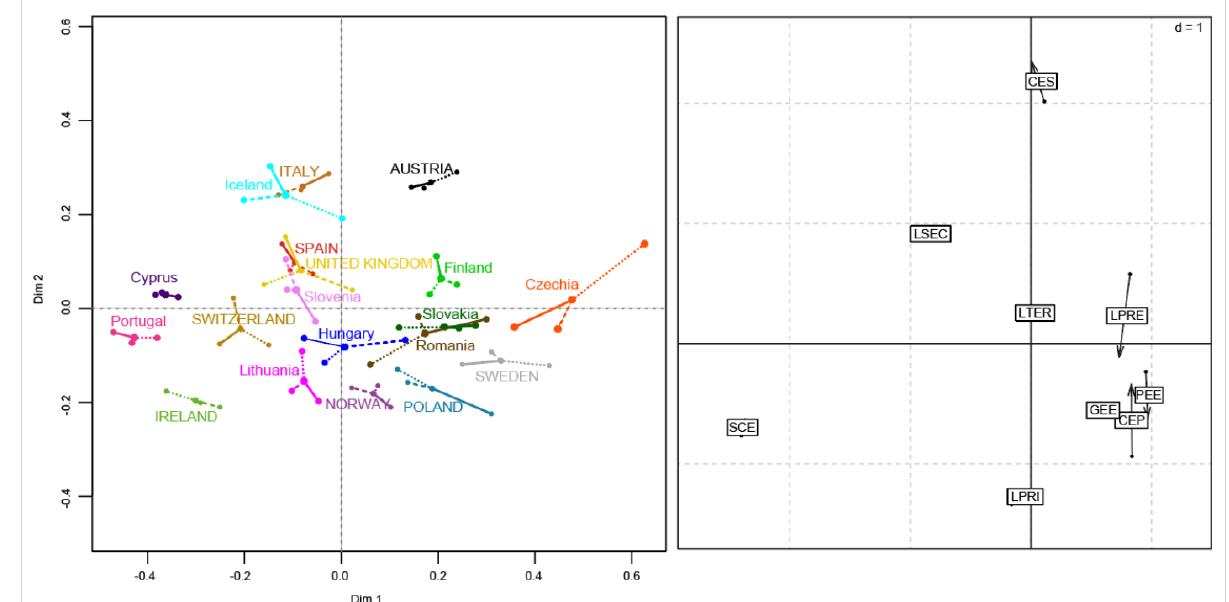
Figure 4. Graphs resulting from GPA method: Representation of high and low-income countries’ compromises and their trajectories ( left ) and co-inertia analysis graph of the two expenditure compromises ( right ). The scale is given by the value d